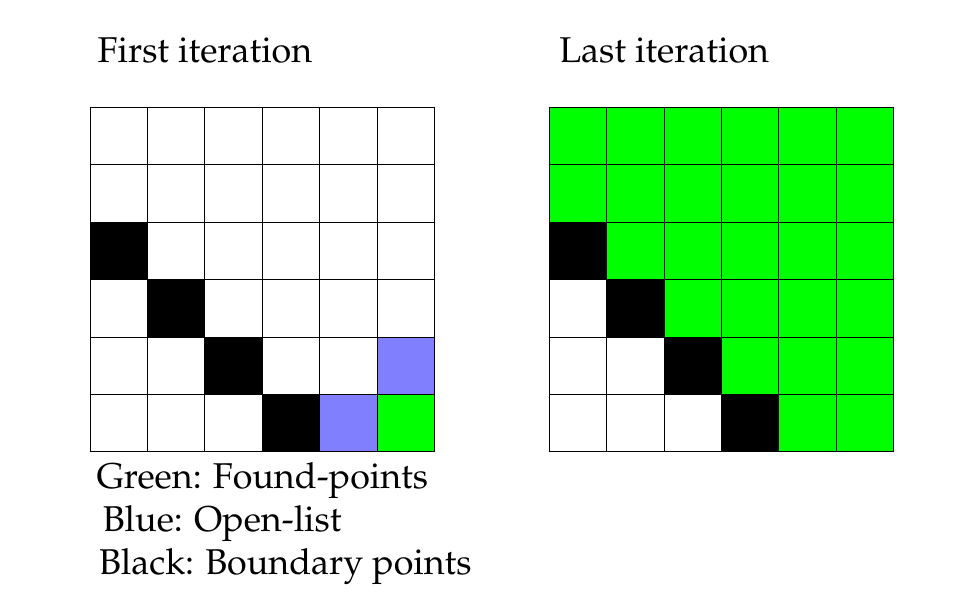
Figure 1. Colour Flood-Fill on the